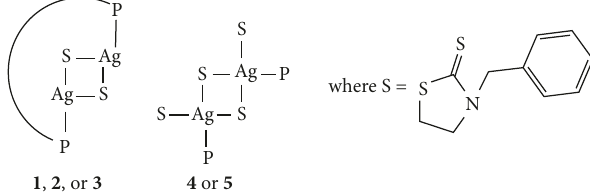
Figure 1: Proposed structure of silver complexes—corresponding P-ligand as listed in Table